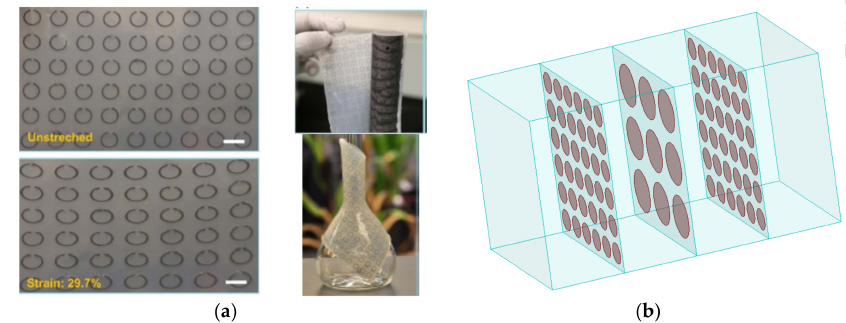
Figure 21. ( a ) Photograph of the un-stretched and stretched meta-skin, wrapped around dielectric nylon rod, flexibility demonstration with a glass flask [182]. ( b ) Topology of the third-order stopband optical FSS. ( a ) Adapted from [182] and reproduced from under Creative Commons Attribution 4.0 International